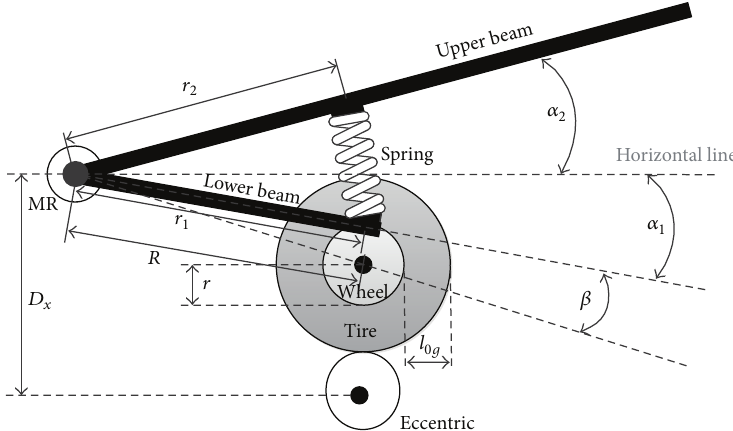
Figure 2: Geometrical diagram of